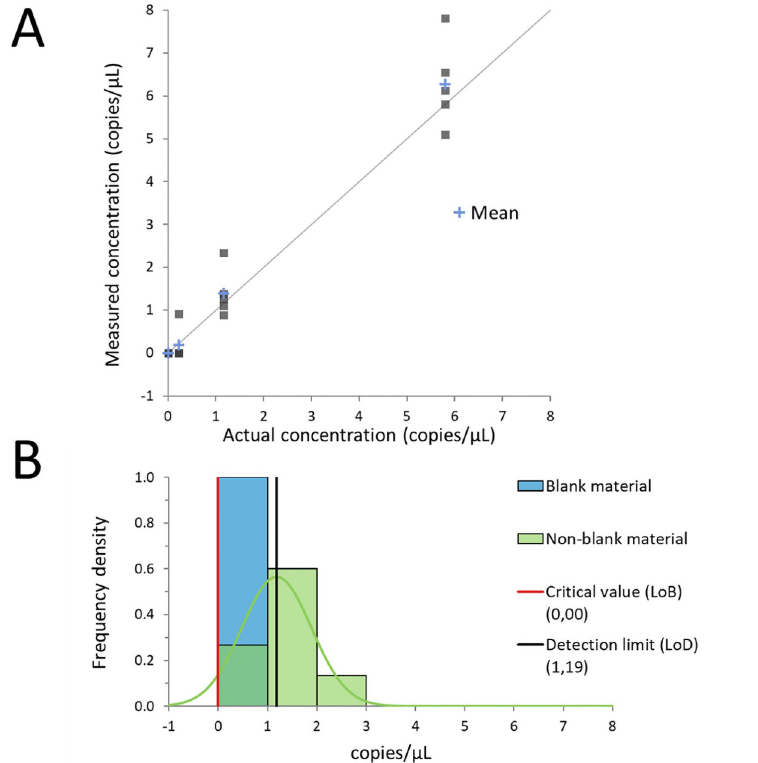
Fig 2. Precision profile analysis of variance for assessing the analytical sensitivity of a digital PCR assay using α and β values of 5% for Limit of Blank (LoB) and Limit of Detection (LOD), respectively.